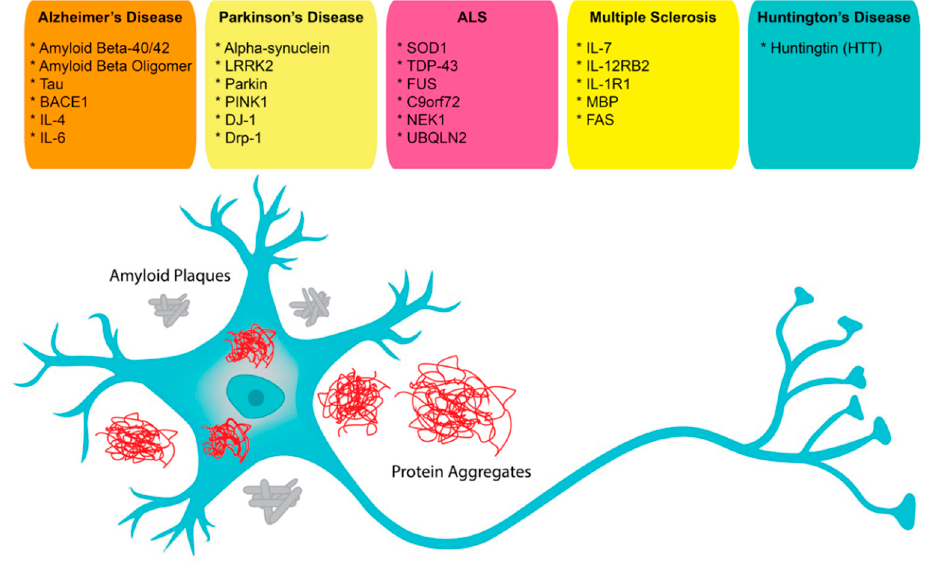
Figure 1. Possible aptamer targets in neuroscience.